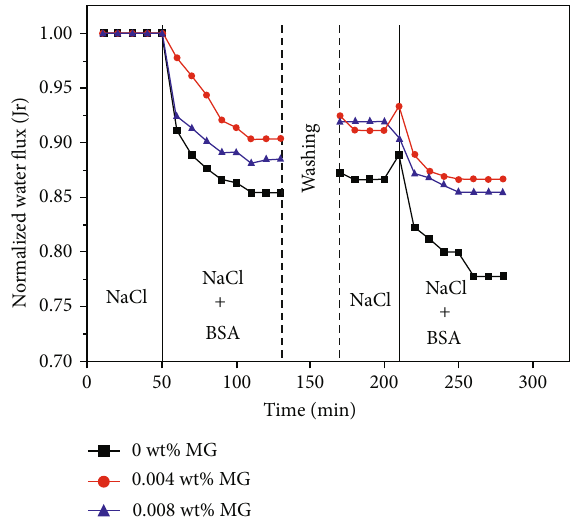
Figure 6: A comparison of fl ux recoveries for the composite membranes prepared with di ff erent MG concentrations.